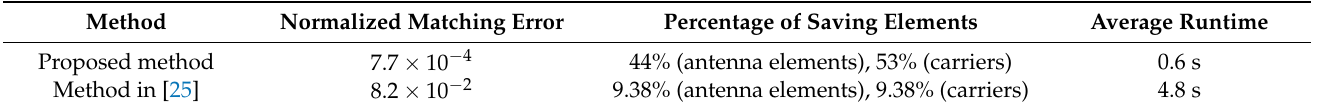
Table 3. The performance comparison of different sparse MCFDA synthesis methods.